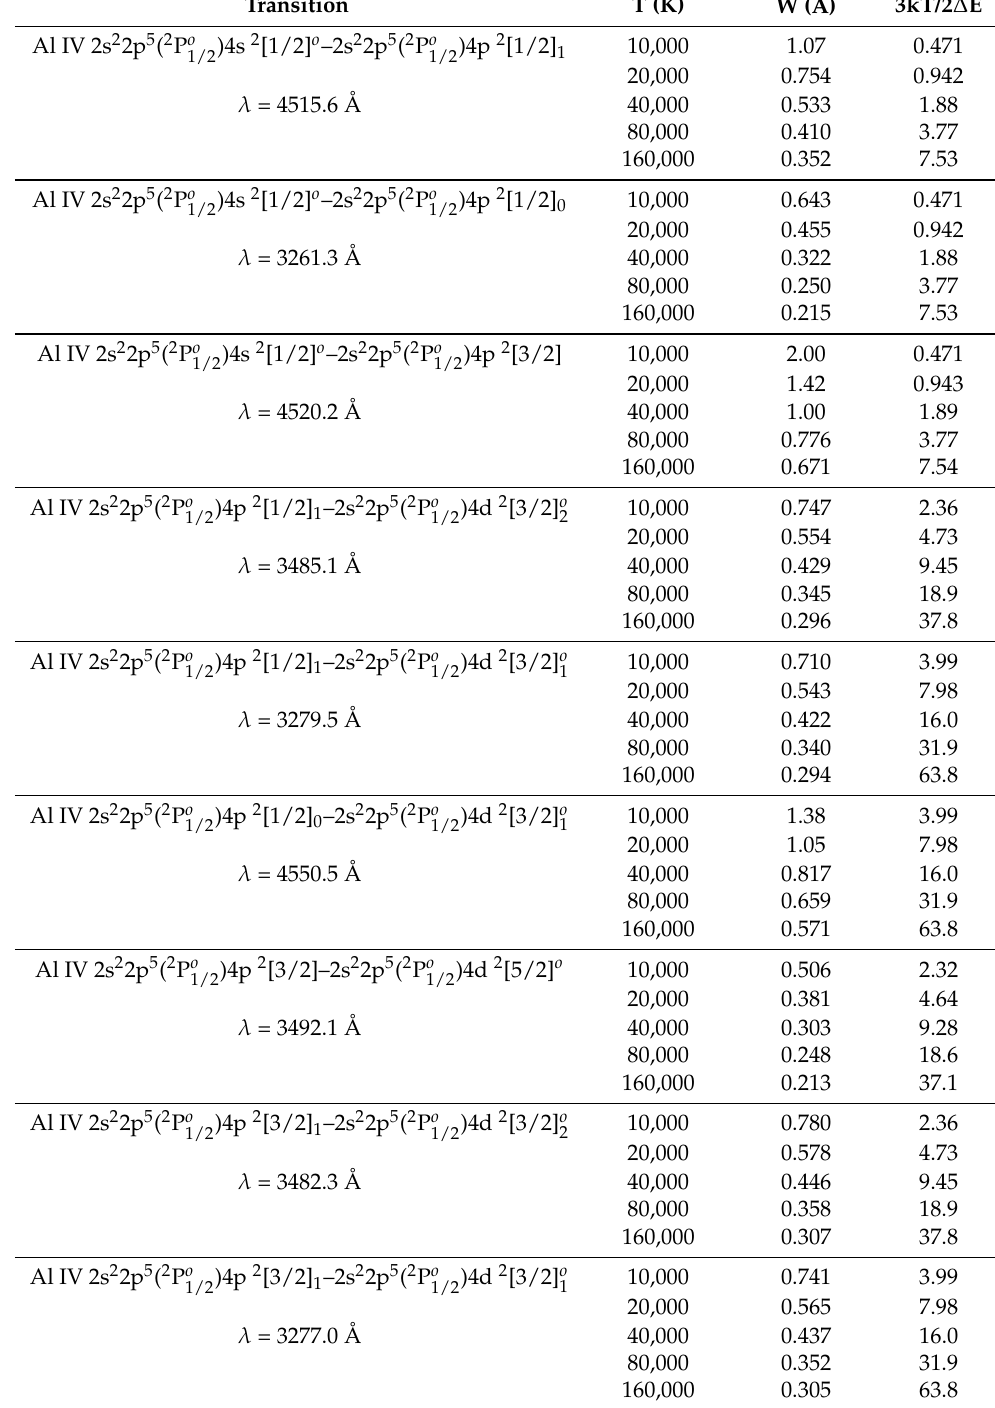
Table 1. FWHM (full widths at half intensity maximum) (W) for Al IV spectral lines broadened by impacts with surrounding electrons, for an electron density of 10 17 cm − 3 and temperatures from 10,000 K to 160,000